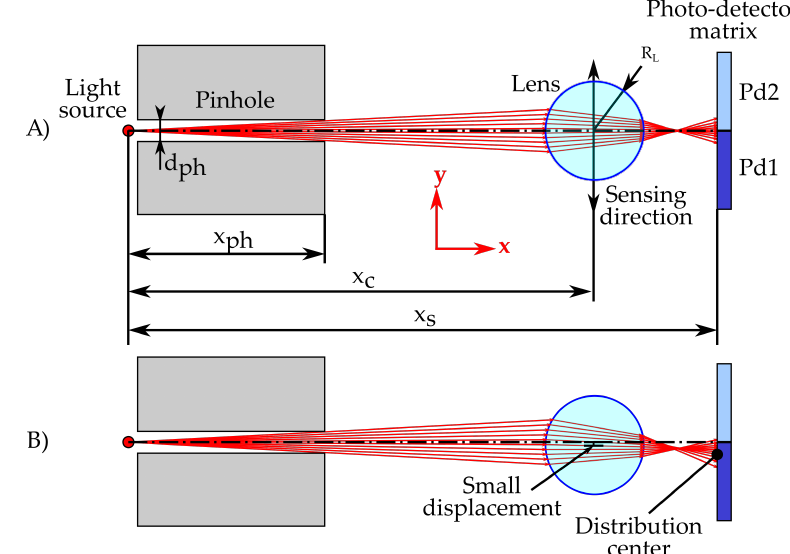
Figure 2. ( A ) proposed optical architecture in nominal position (perfect alignment) and geometrical parameters that determine the sensor response. ( B ) resulting light distribution in the photo-detecting surface after applying a small displacement in the lens in the y -direction (direction of the force to be